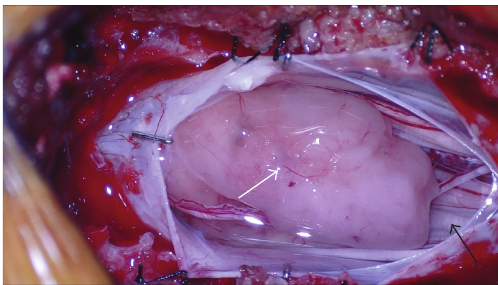
Figure 2: Intraoperative photo shows a tan, fleshy tumor (white arrow) within the thecal sac, clearly outside the cauda equina (black